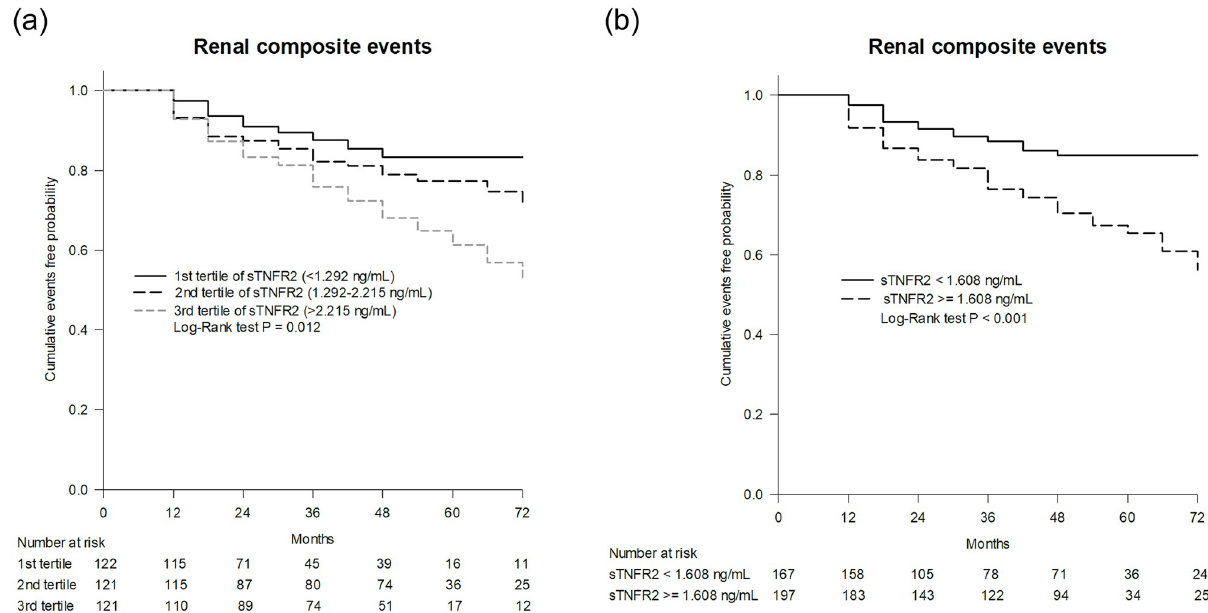
Fig 2. Kaplan-Meier curves of cumulative event-free survival of renal events (a composite of a > 30% reduction of the estimated glomerular filtration rate and/or the progression of albuminuria stages) in patients with type 2 diabetes according to: (a) the tertiles of soluble tumor necrosis factor receptor 2 (sTNFR2) levels and (b) the threshold value of sTNFR2 ( � 1.608 ng/mL vs. < 1.608 ng/mL). Differences between curves were analyzed with log-rank statistics.